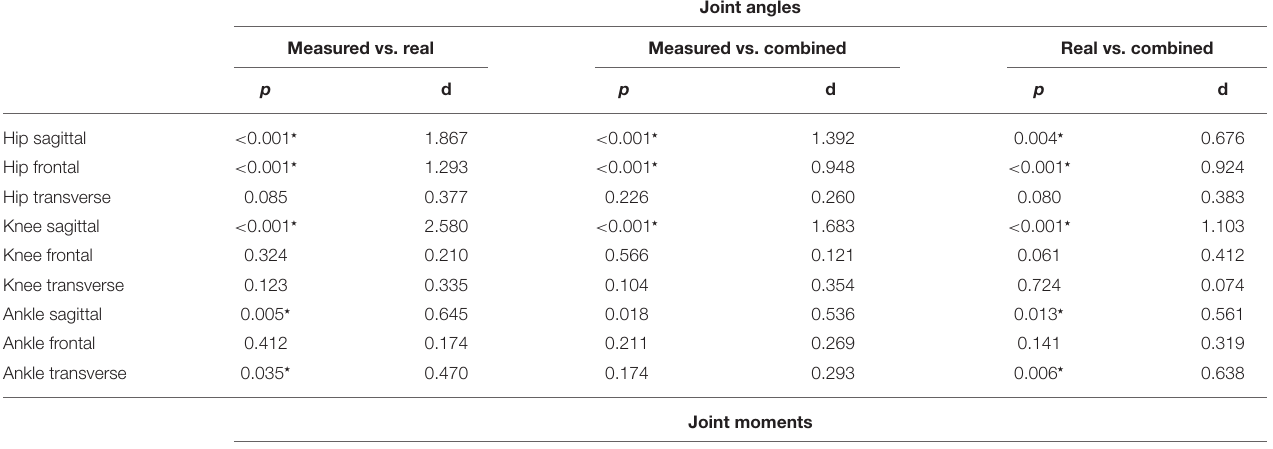
Joint angles Measured vs. combined